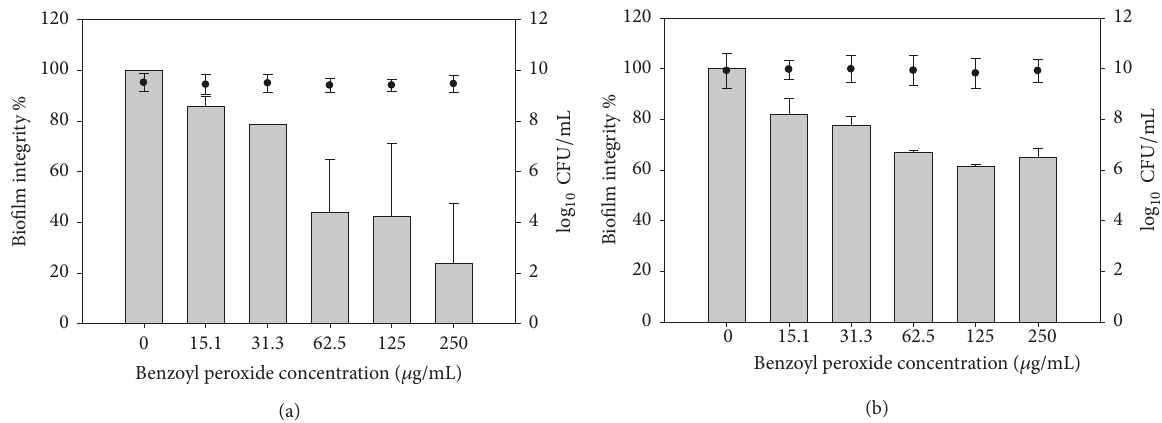
Figure 5: Inhibition of L. monocytogenes (a) and E.coli (b) biofilm by benzoyl peroxide. Biofilm integrity (gray colour); cell survival ( e ).